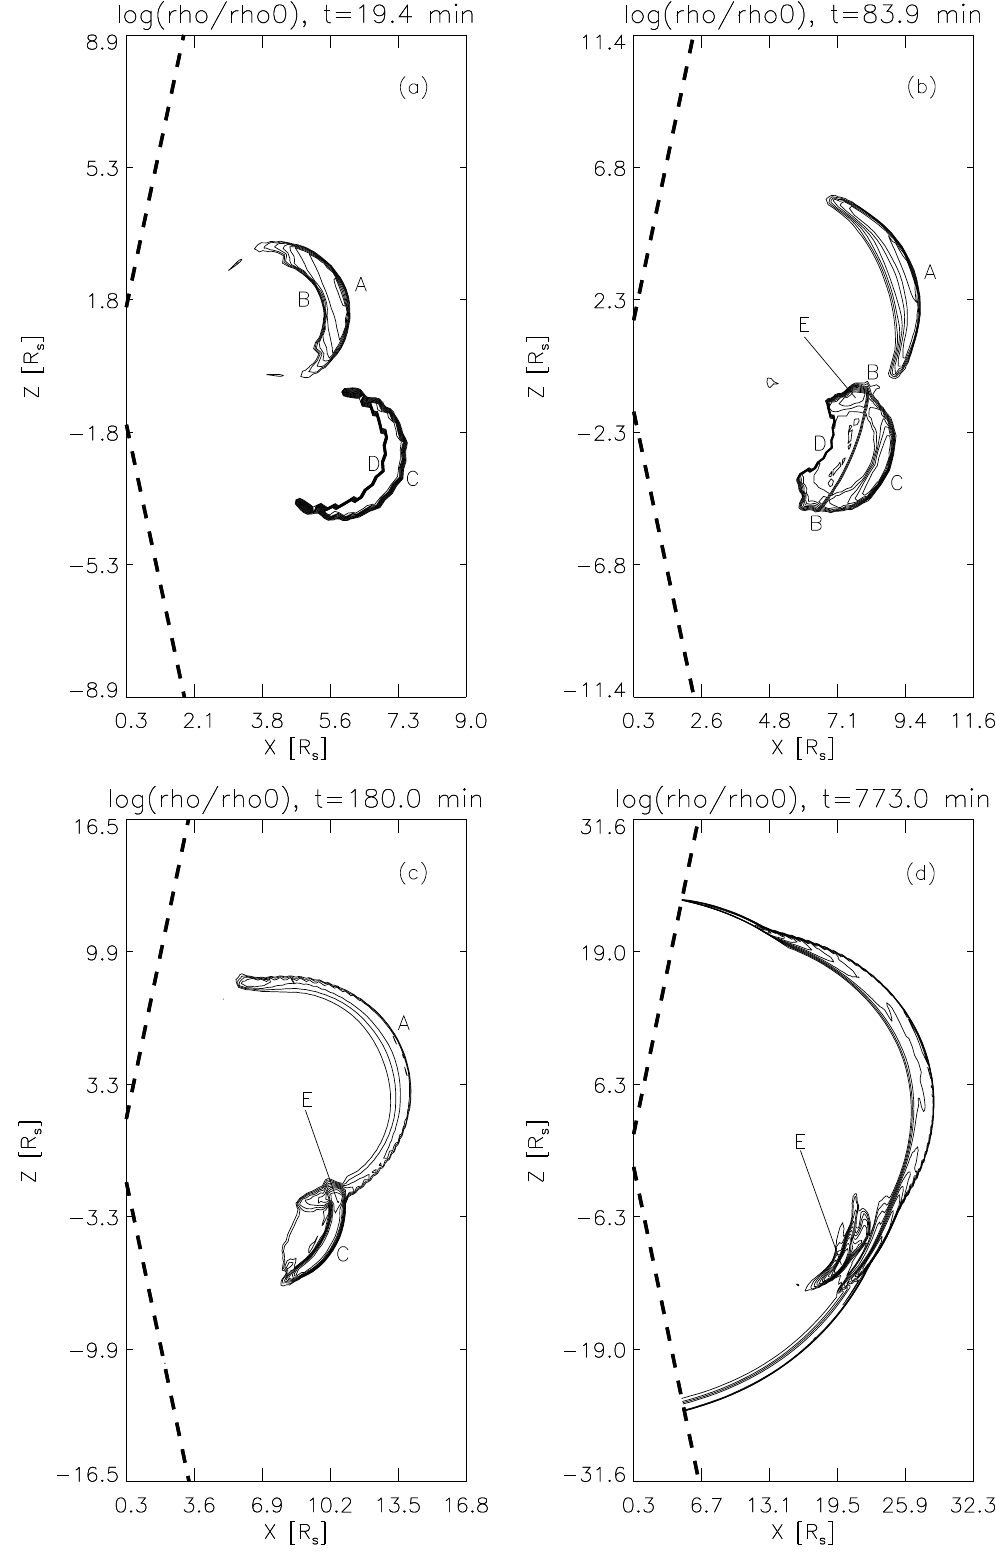
Fig. 2. Contour line plots of the change in density for the simulation shown in Fig. 1. The labels A–E are discussed in the